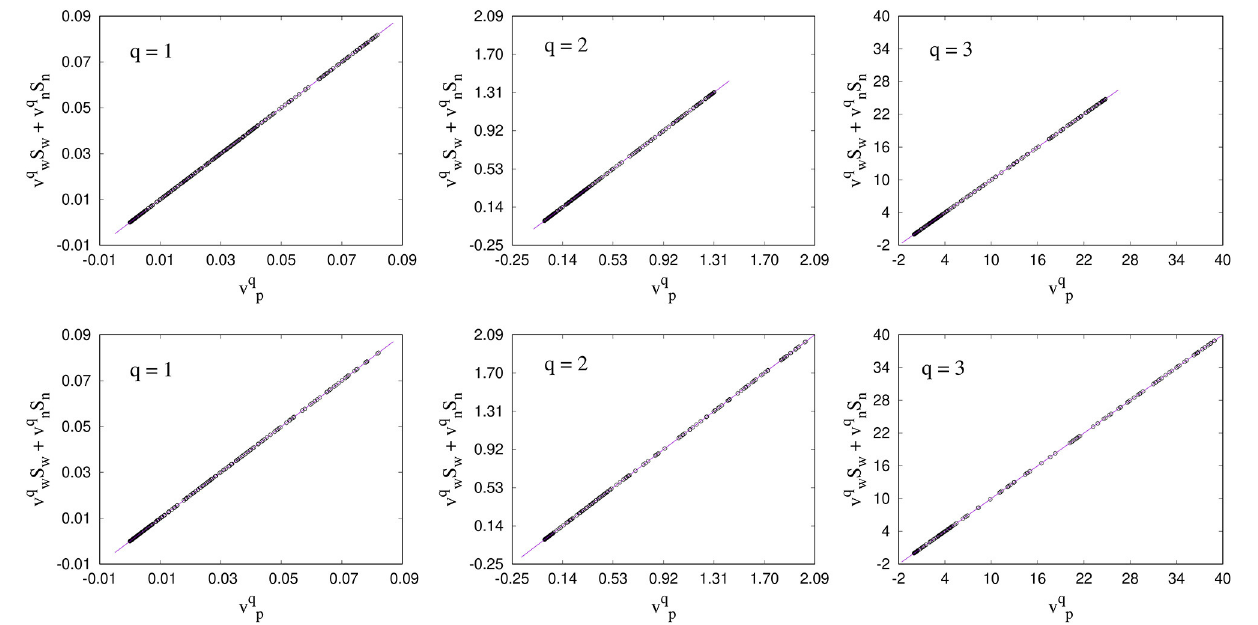
FIGURE 1 | Verification of the relations (11), (45), and (59) between the steady-state seepage velocities v p , v w , and v n , and their higher moments for the 2D regular network. The top row represents the direct approach of measurements using Equations (79), (80), and (81). The bottom row corresponds to the velocities measured from the differential area distributions defined in Equations (58), (60), and (61). v p has a unit mm/s. Subsequently, for q mm 3 /s, respectively.